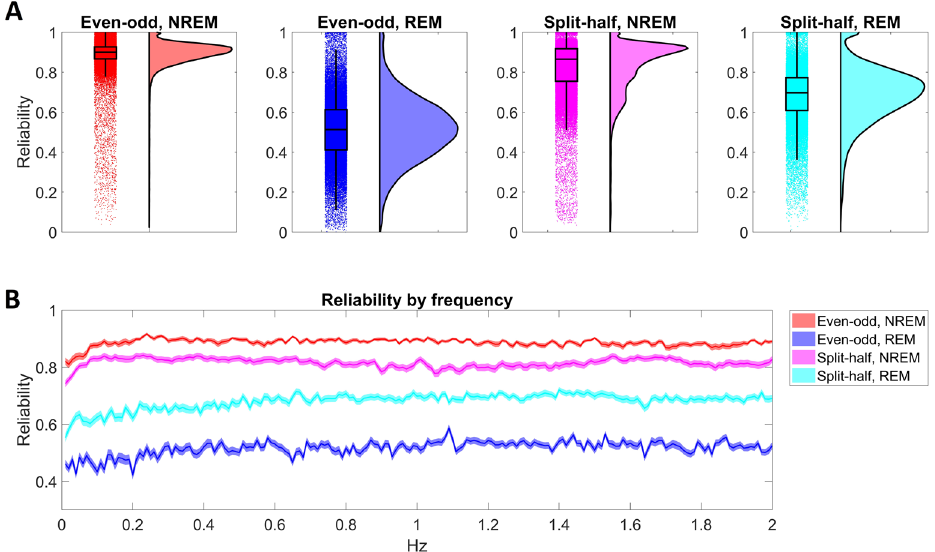
Figure 4. The reliability of the sleep EEG envelope spectrum. ( A ) Shows raincloud plots 55 ) by vigilance state and reliability type, showing raw data overlain with box plots on the left side and kernel density curves on the right side. Data from all frequency bands, envelope frequency bins and scalp channels are pooled for estimating the box plot, while individual instances are shown as data points. ( B ) Illustrates reliability by envelope frequency bin. Data from all frequency bands and scalp channels are pooled, shading indicates 95% confidence intervals of the